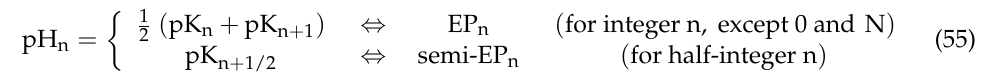
Table 3. Internal equivalence points (based on pK values in Table